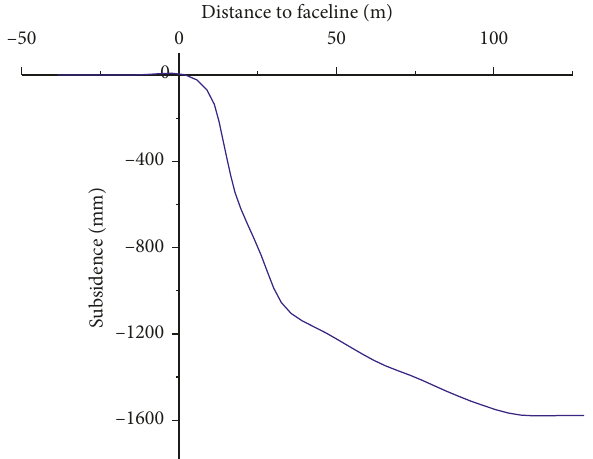
Figure 7: Half-subsidence curve of the voussoir beam structure.